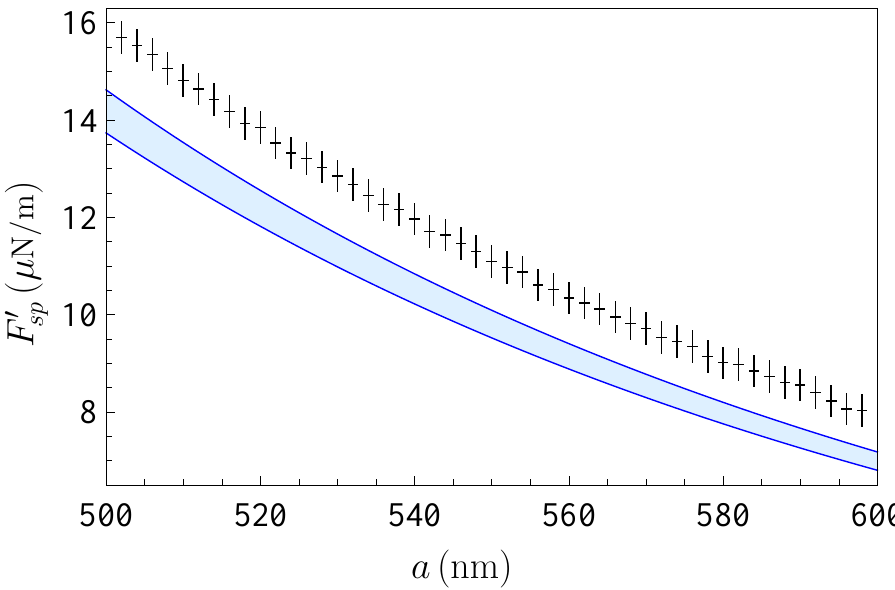
Figure 7. The gradients of the Casimir force between an Au-coated sphere and an Au-coated plate measured using a micromechanical torsional oscillator [22] (crosses) are compared with the theoretical predictions of Lifshitz theory using all available sets of the optical data for the complex index of refraction of Au extrapolated to zero frequency by the Drude model (blue